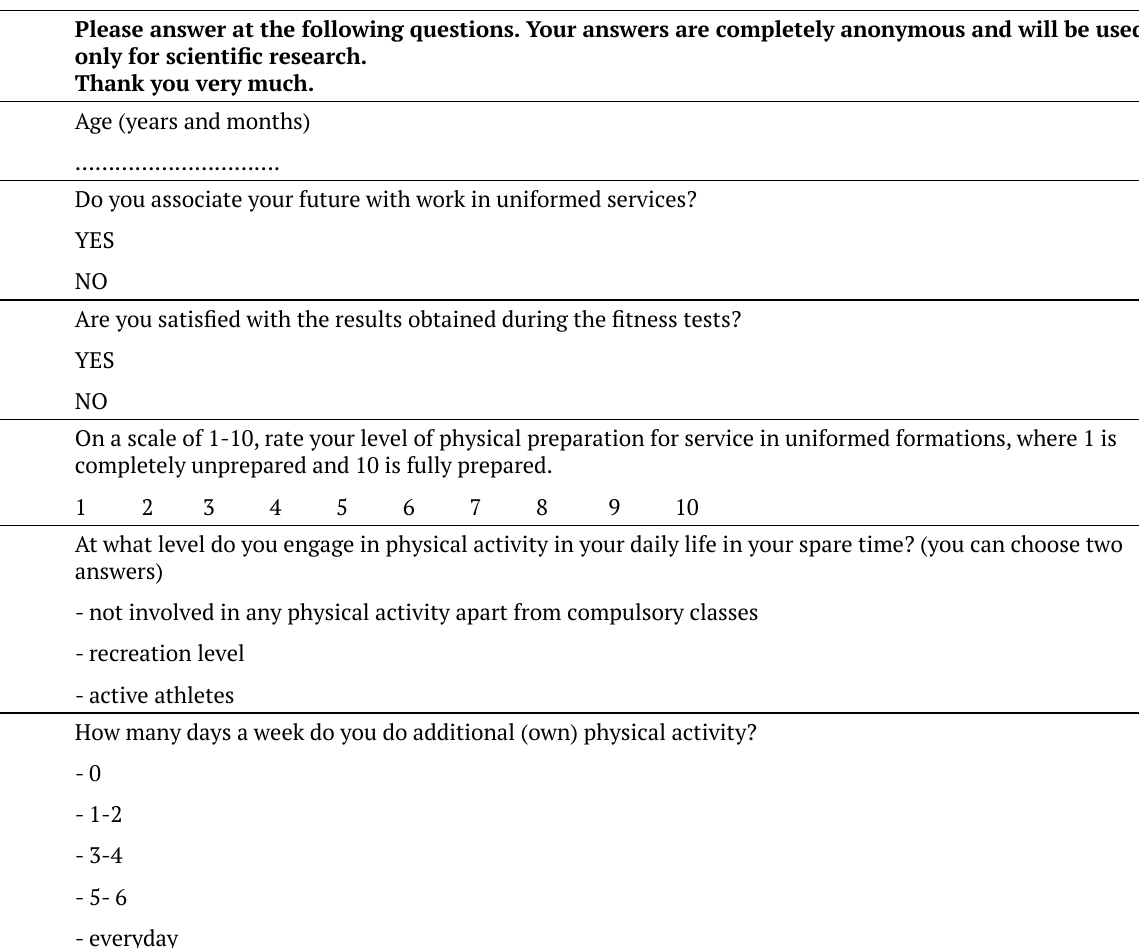
Table 1. Research questionnaire